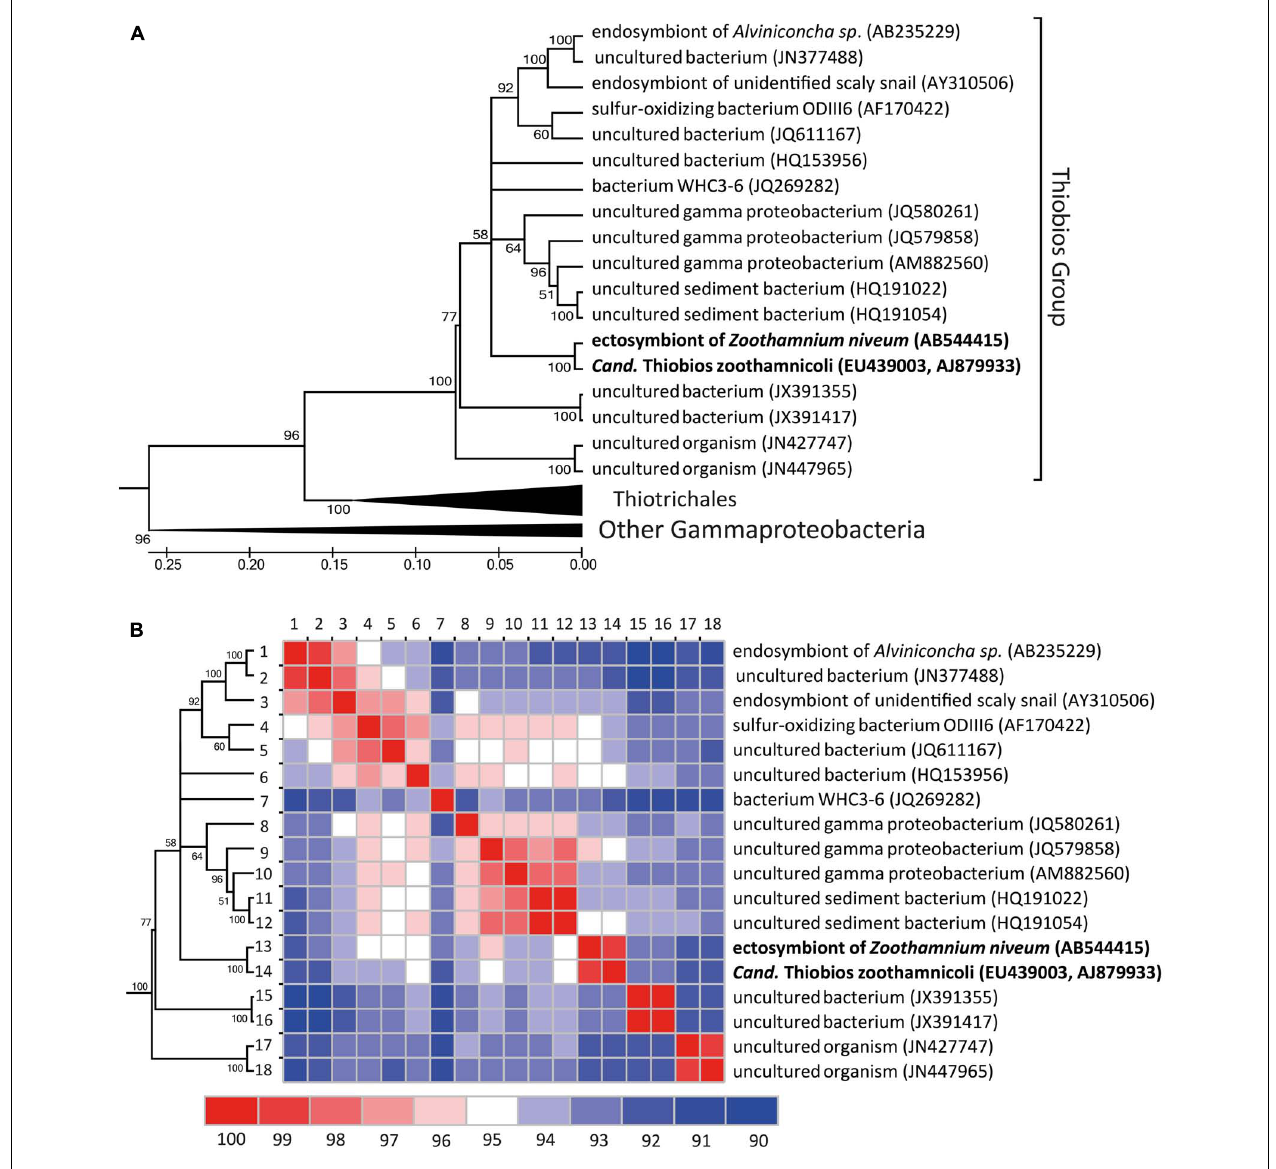
FIGURE 6 | Phylogenetic diversification of the Cand. Thiobios zoothamnicoli neighborhood. (A) Maximum likelihood phylogenetic tree (GTR model, 1000 bootstraps) of all long ( > 1300 nt), with good pintail value ( > 60) and non-redundant 16 rRNA sequences similar to Cand. Thiobios zoothamnicoli available in the SILVA database (Quast etal., 2013). The tree with the highest log likelihood is shown and is drawn to scale, with branch lengths measured in number of